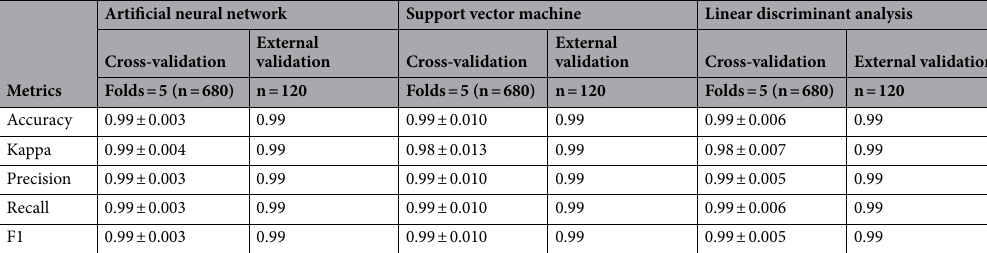
Table 1. Comparation of the artificial neural network, support vector machine and linear discriminant analysis algorithms to assess soybean seed quality using autofluorescence-spectral data, and the model performances based on accuracy, kappa, precision, recall and F1. The models were created using autofluorescence-spectral data extracted from non-aged seeds and seeds aged for 12, 24 and 48 h ( n = 800 seeds).